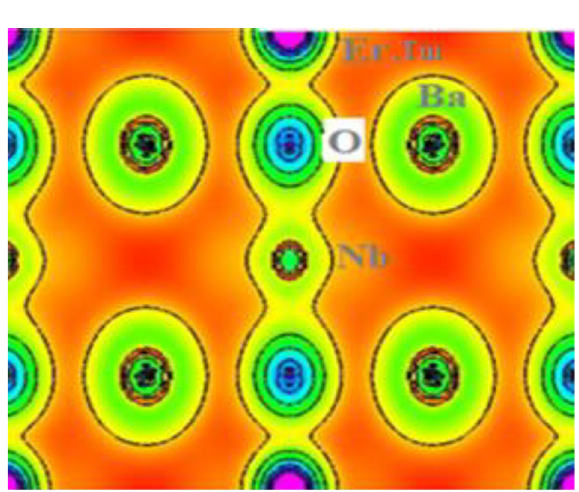
Figure 7. Spatial charge density description of Ba 2 Er/TmNbO 6 oxide